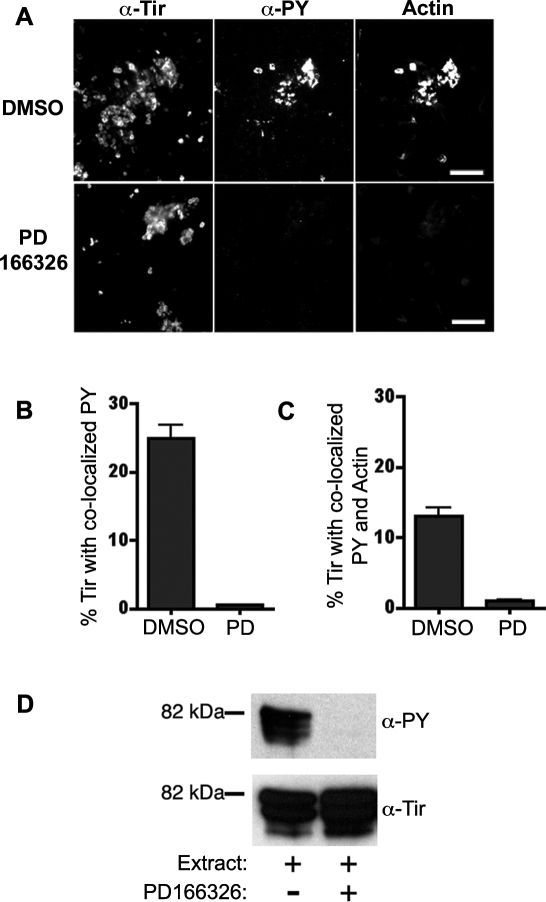
PD-166326 Blocks Actin Polymerization and Tir Phosphorylation in RBC Infected with EPEC and Exposed to Extract(A) Images of RBC infected with EPEC and exposed to low-ATP extract containing either 10 μM PD-166326 or an equivalent dilution of carrier (DMSO). Cells were stained with anti-Tir antibody, anti-PY 4G10 antibody, and Alexa-488-phalloidin to visualize actin.(B) Quantitative analysis of colocalization of PY staining and Tir in RBC infected with EPEC and exposed to low-ATP extract containing either 10 μM PD-166326 or DMSO.(C) Quantitative analysis of colocalization of actin staining with PY and Tir in RBC infected with EPEC and exposed to low-ATP extract containing either 10 μM PD-166326 or DMSO.(D) Western analysis using anti-PY 4G10 antibody and anti-Tir antibody of the TX-100 soluble fraction of RBC infected with EPEC and exposed to low-ATP extract containing 10 μM PD-166326.